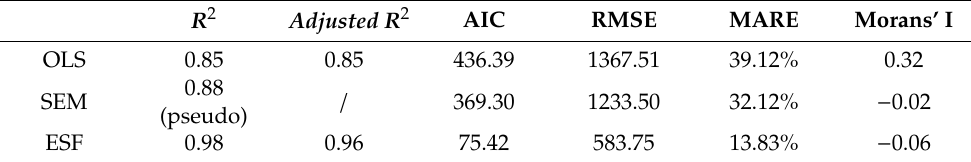
Table 10. Model performance in 2017.